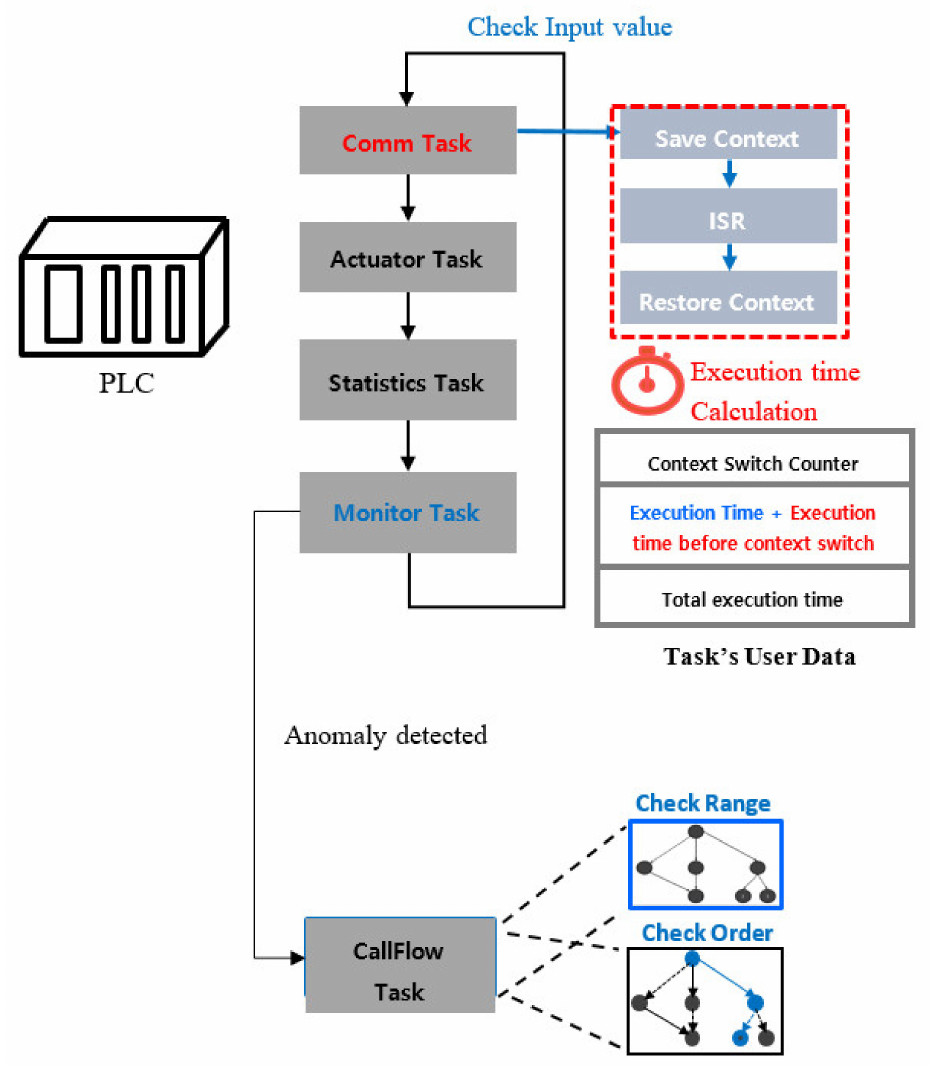
Figure 1. Measurement of task execution time and control-flow anomaly